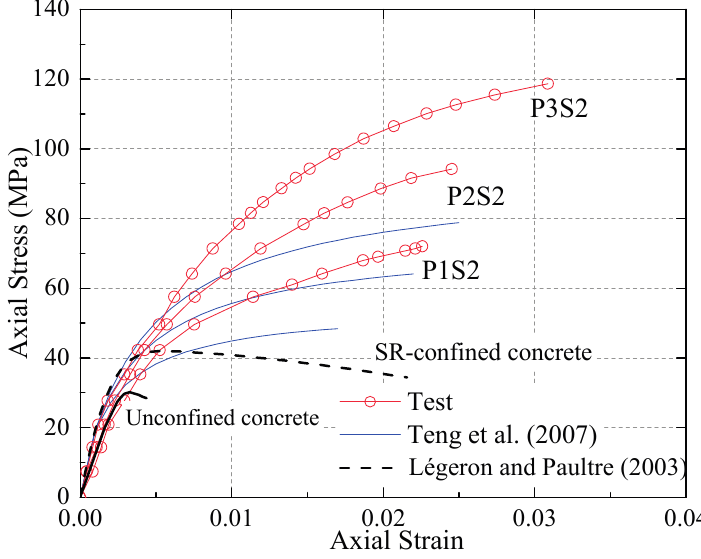
Figure 10. Comparison between axial stress–strain curves of GFRP-confined concrete or SR-confined concrete and the experimental results of GFRP–SR confined